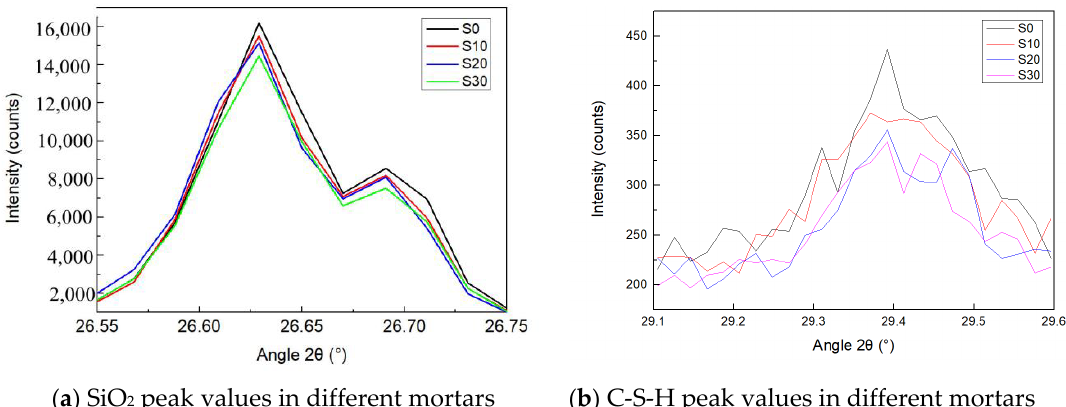
Figure 16. XRD patterns of AASSC with different contents of silico-manganese slag.